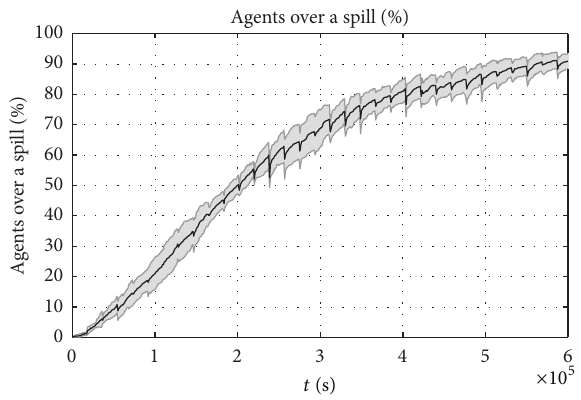
Figure 9: Percentage of agents over an oil slick with respect to time (in seconds). Ten different experiments have been carried out, showing the average and